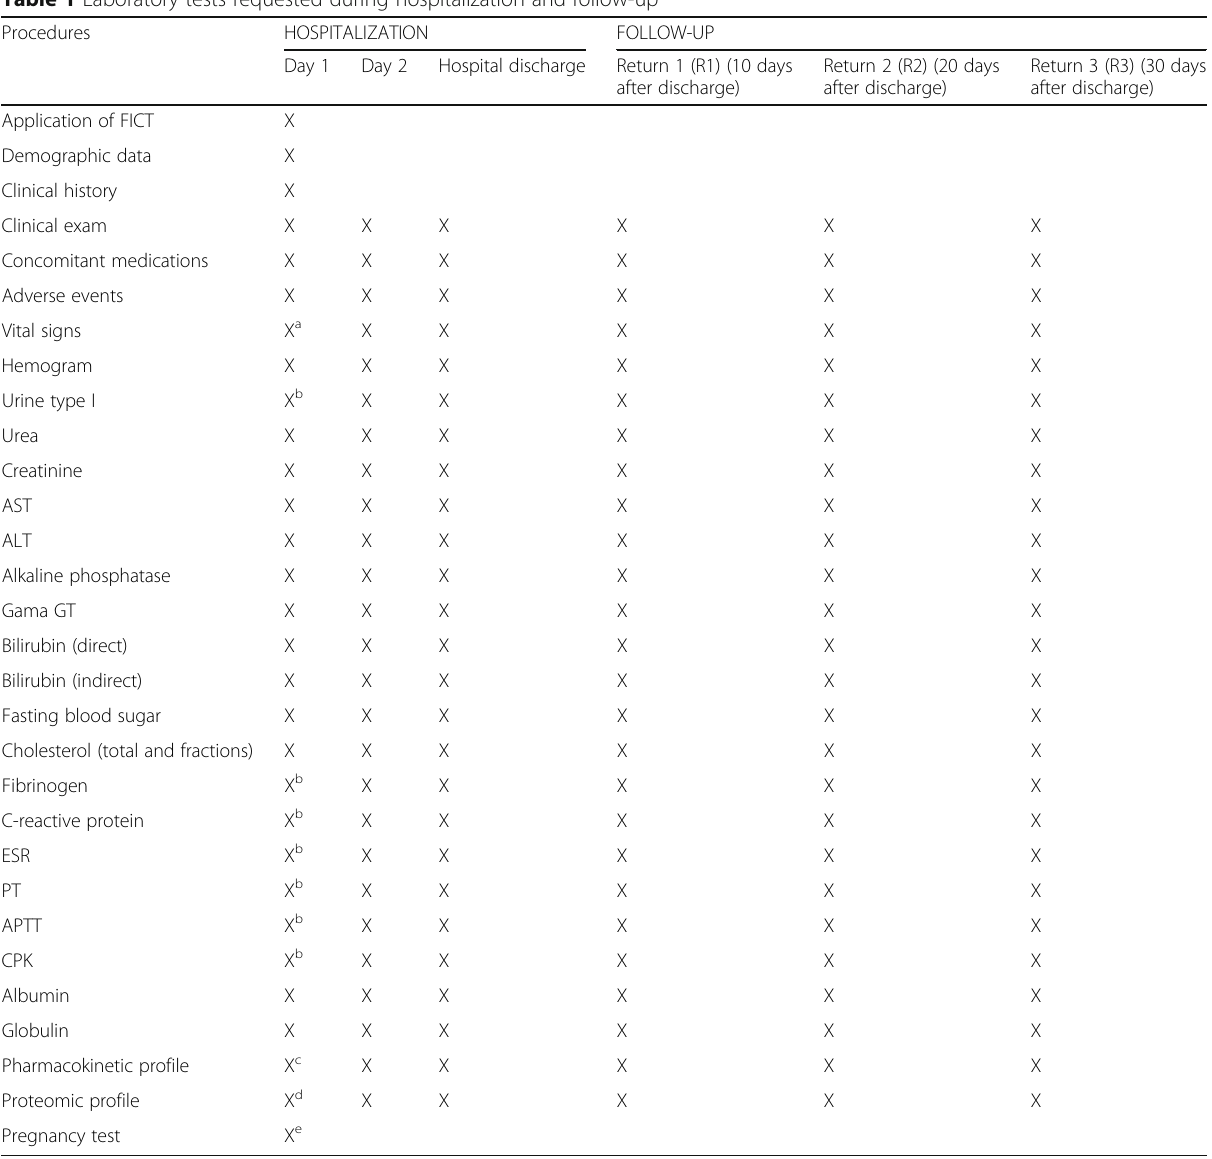
Table 1 Laboratory tests requested during hospitalization and follow-up